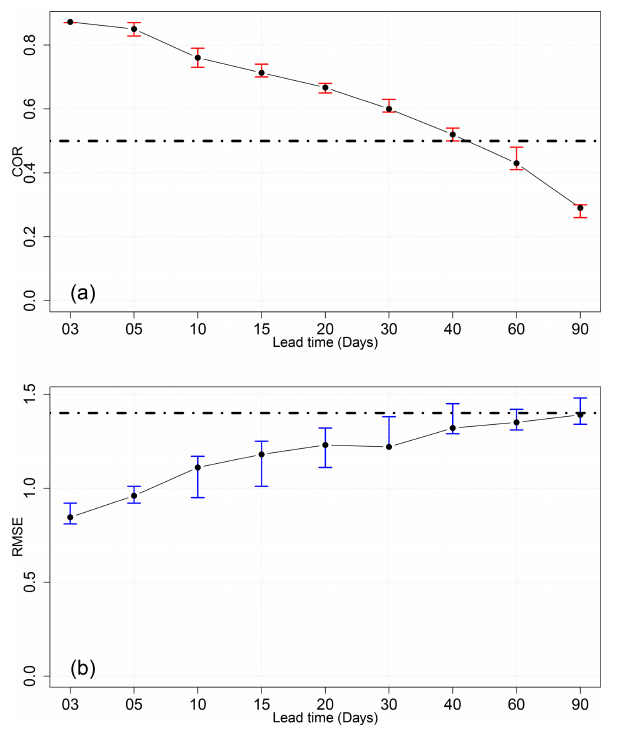
Figure 8. The COR (a) and RMSE (b) for the different lead times of forecasts from 3 to 90d over the period from 1979 to 2020. Con- fidence intervals are obtained with a bootstrap with 1000